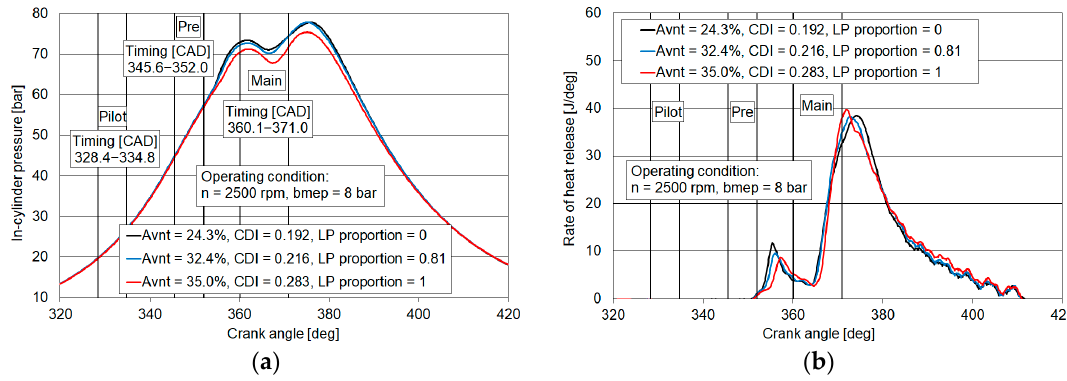
Figure 5. Influence of EGR and Variable Nozzle Turbine (VNT) control on pressure diagrams ( a ) and heat release; ( b ) (HP and Low Pressure, LP, loops activation).